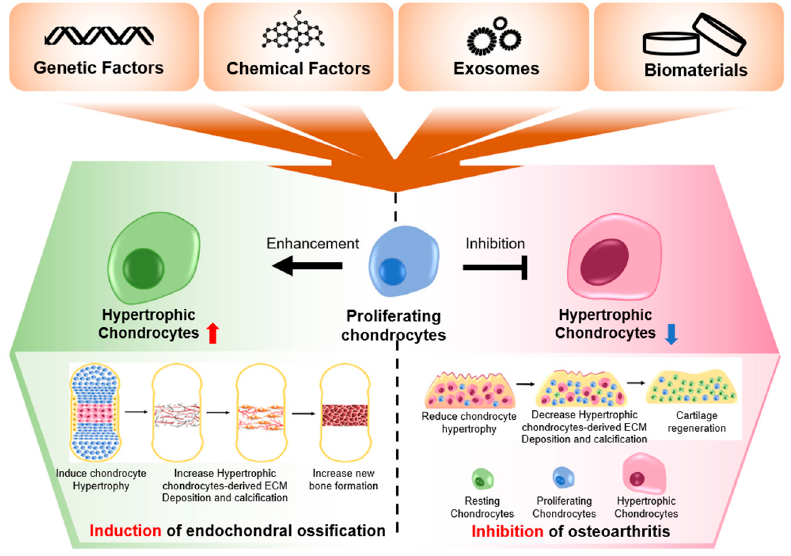
Figure 3. The expected effects of preventing or promoting chondrocyte hypertrophy, using various factors.